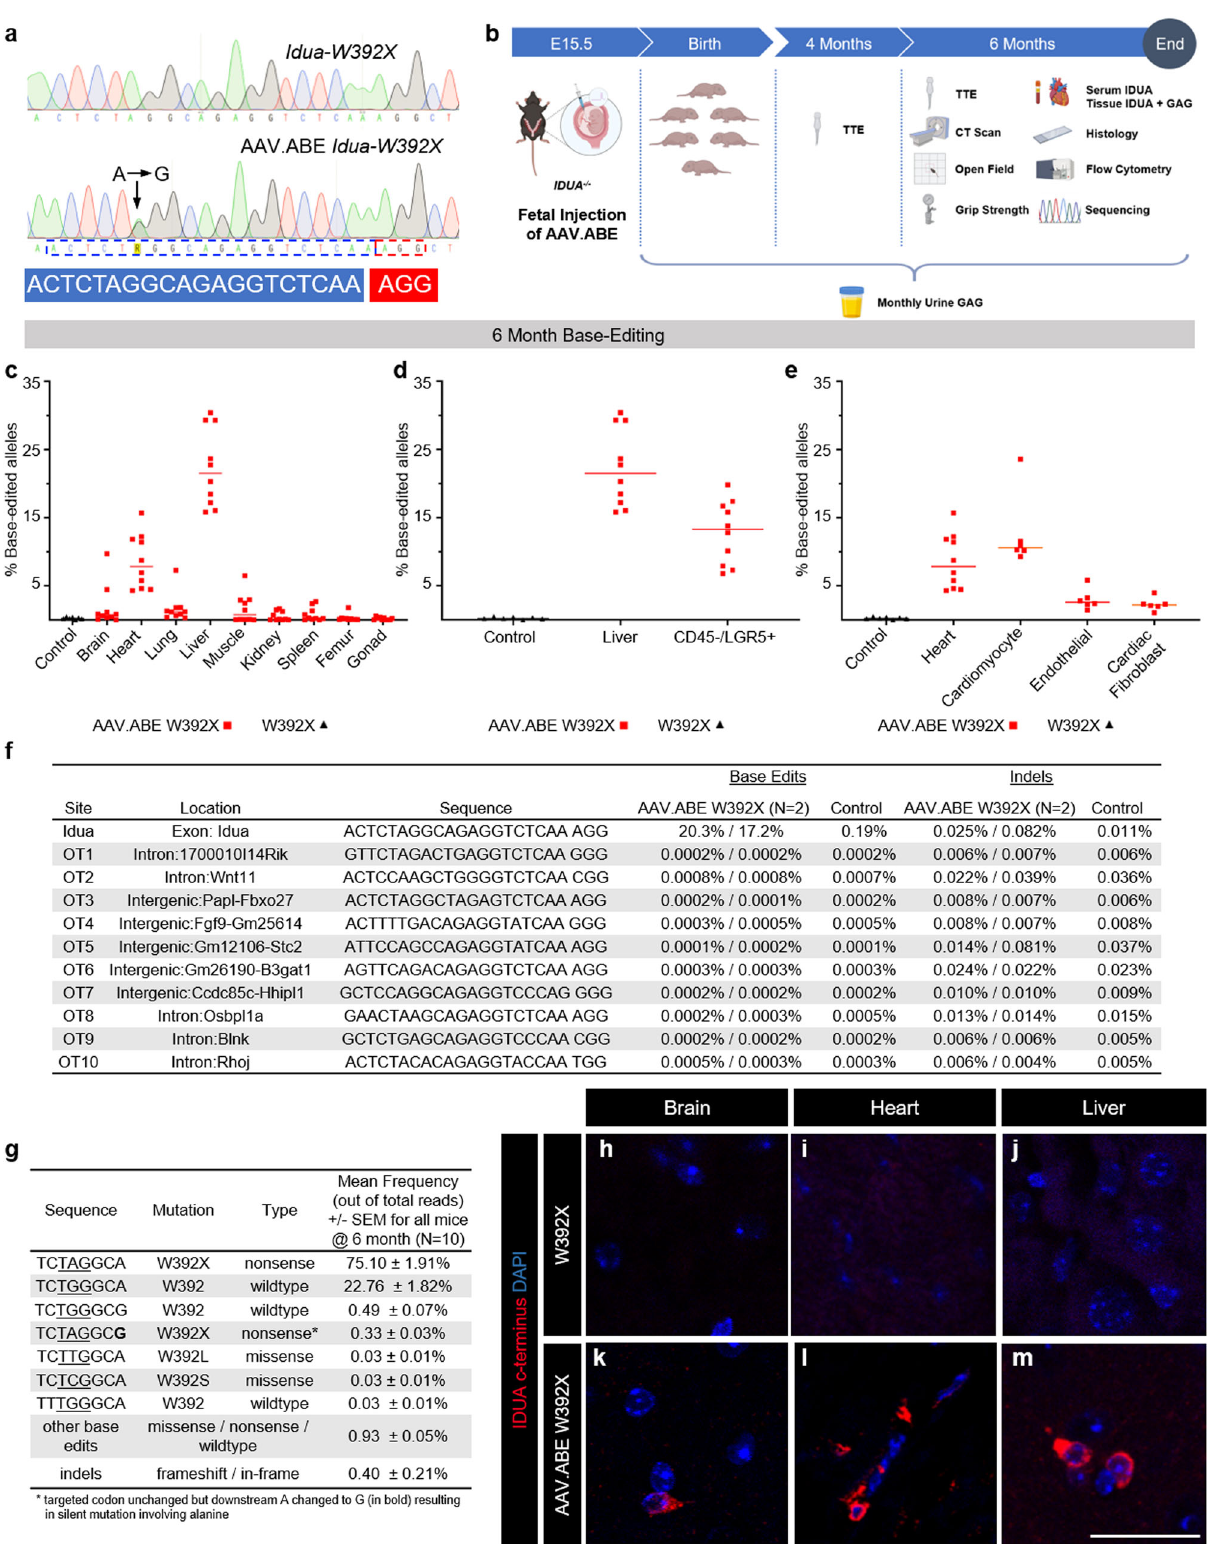
optimized ABE7.10 (ABEmax) 40 and gRNA with the target adenine mutation at position 6 within the 20-base protospacer sequence upstream of an NGG protospacer-adjacent motif (PAM) were packaged in two split-intein AAV9s (AAV.ABE. Idua) (Fig. 1a). In an initial screening experiment, two E15.5